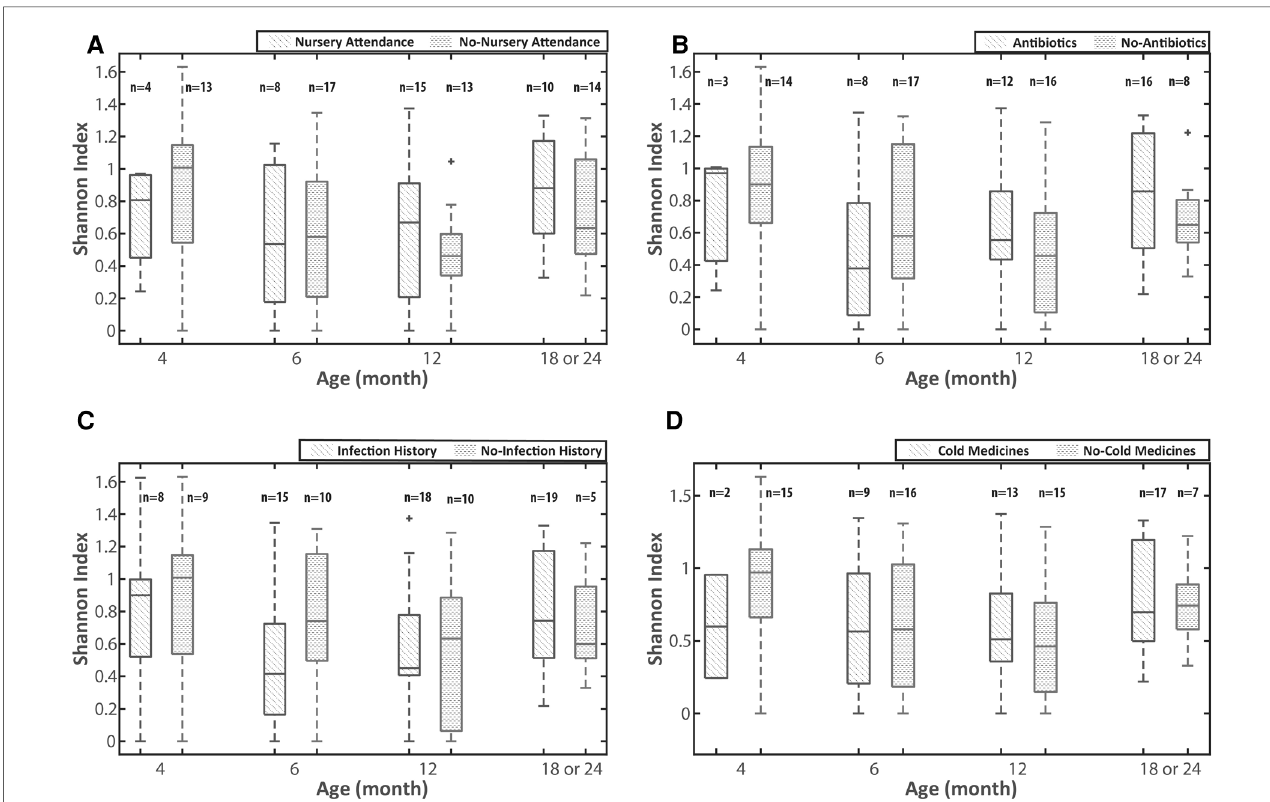
FIGURE 1 The impact of environmental factors on the diversity of the URT microbiota. ( A ) early nursery attendance, ( B ) use of antibiotics, ( C ) URTI episodes and ( D ) use of cold medicine. The Shannon index was used for the analyses of the diversity of the URT microbiota. The analyses were performed on the 4 age groups (around 4, 6, 12 and 18 or 24 months old). URTI episodes and the uses of antibiotics and cold medicines are de fi ned as the histories between the previous and present samplings. URTI: upper respiratory tract infection, URT: upper respiratory